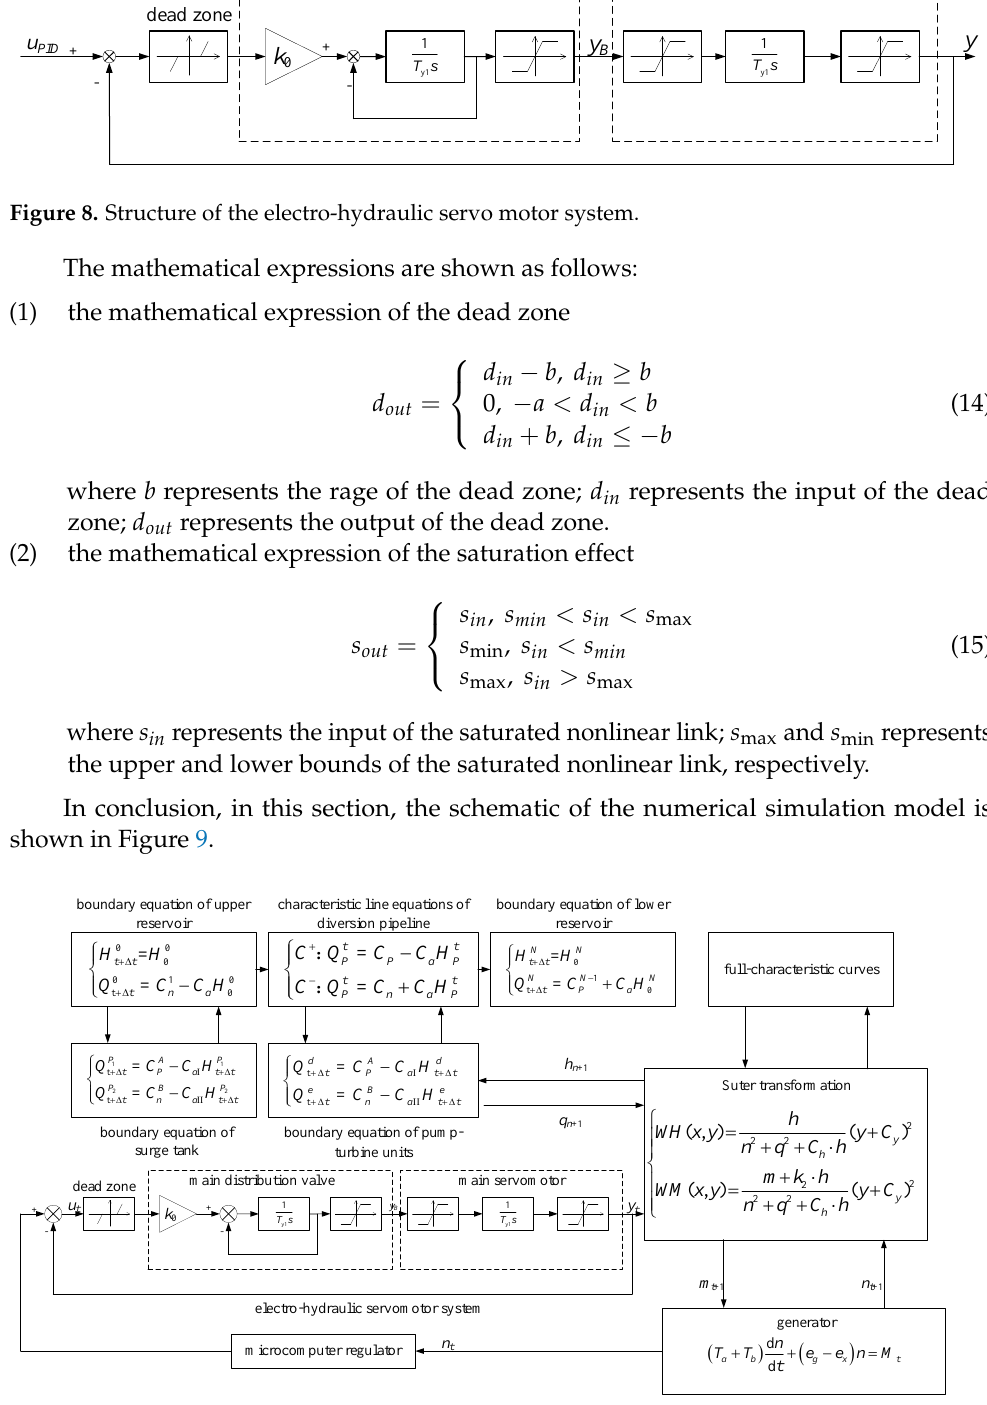
Figure 9. Schematic of the numerical simulation model.